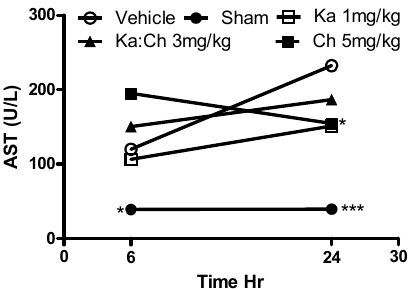
Figure 7. Time course profile of kaempferol and chrysin individual and combination treatments on serum aspartate aminotransferase (AST) levels in septic mice determined using ELISA kit. Each point represents the mean of four experiments. * p ≤ 0.05 and *** p ≤ 0.001 versus CLP/vehicle (Student’s t -test).